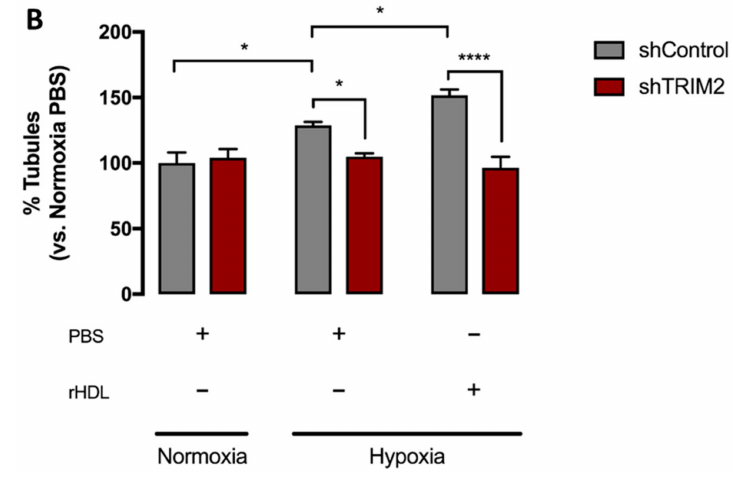
Figure 6. Tubulogenesis following exposure to hypoxia in HCAECs transduced with lentivirus containing shControl or shTRIM2 treated with either PBS or rHDL compared to cells under normoxic conditions. ( A ) Representative images of tubule formation were photographed under light microscopy. Scale bars, 50 µ m; ( B ) Number of tubules was counted and analyzed using ImageJ software. Results are mean ± SEM. * p < 0.05, **** p < 0.0001 by two-way ANOVA with post hoc analysis using Bonferroni’s multiple comparisons test.